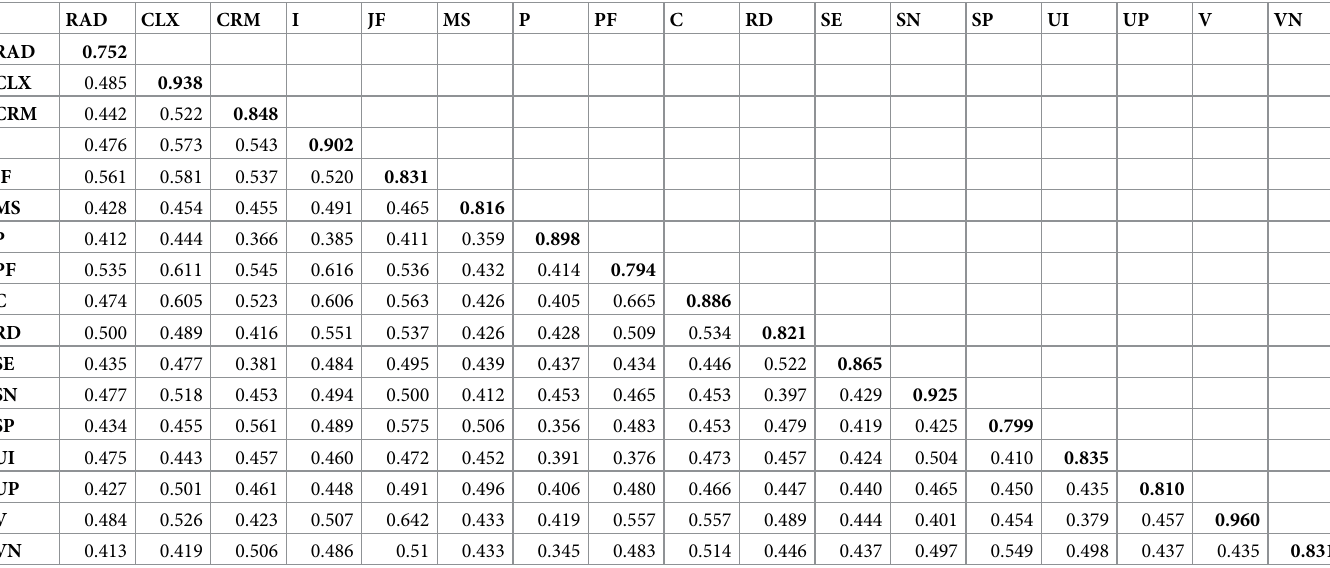
Table 3. Inter-construct correlations and discriminant